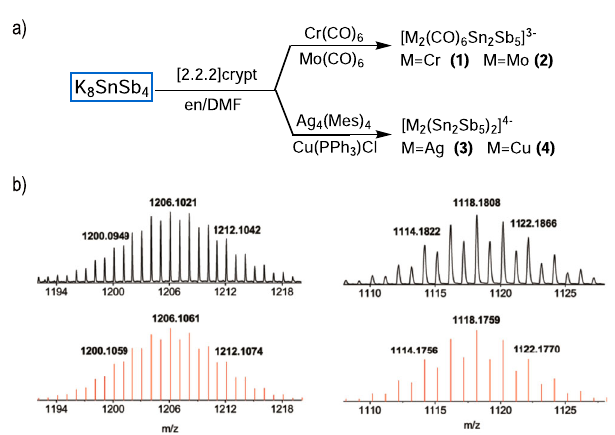
Fig. 2 Reaction diagram and major ESI ( − ) mass spectra. a Reaction diagram for the synthesis of clusters 1 – 4 . b ESI ( − ) mass peaks corresponding to [Cr 2 (CO) 6 Sn 2 Sb 5 ] − (left) and [Mo 2 (CO) 6 Sn 2 Sb 5 ] − (right). The experimental mass distributions are depicted in black, and the theoretical masses of the isotope distributions are shown in red (the experimental values are labeled to the fourth digit.